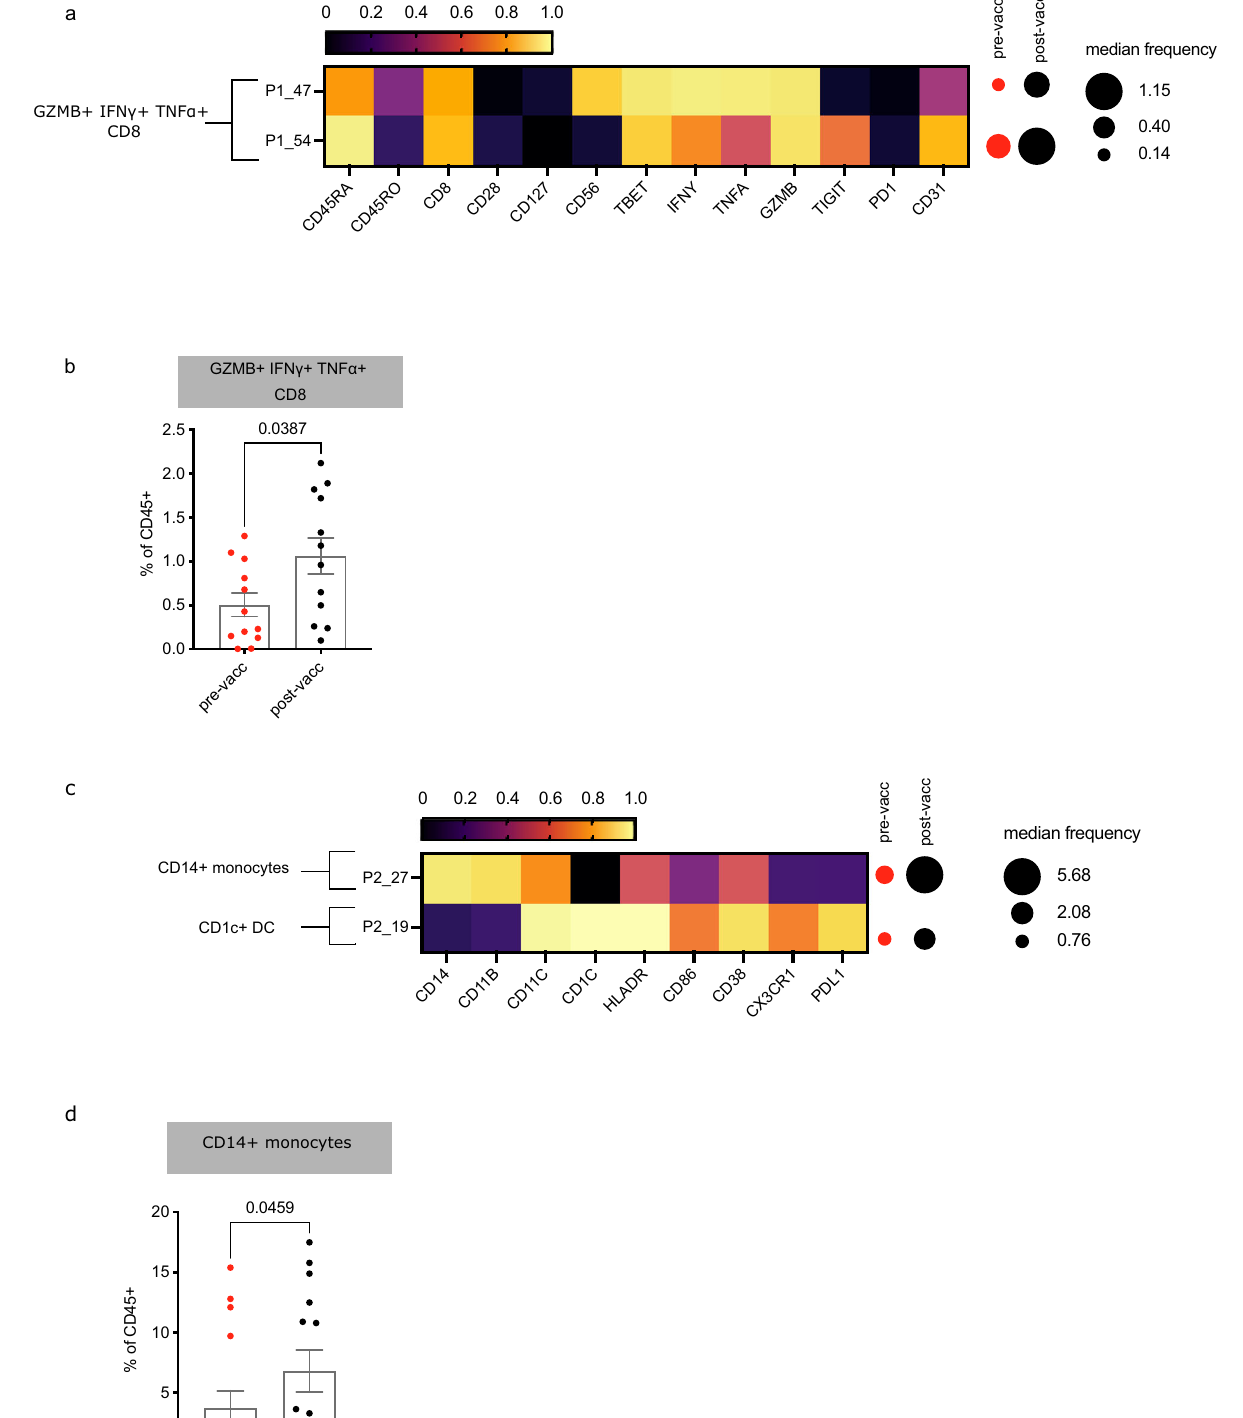
Fig. 2 | Vaccination is associated with increases in cytotoxic CD8 T cells and antigen presenting monocytes. Mass cytometry data was clustered by FlowSOM and analysed for clusters that differed pre (red) and post (black)-vaccination. a Cluster phenotypes identi fi ed using a T cell focused panel (P1). b Manually gated cytotoxic CD8 T cells. Pre-vaccination: n =12 patients, post-vaccination: n =12 c Cluster phenotypes identi fi ed using a B cell/APC focused panel (P2). d Manually